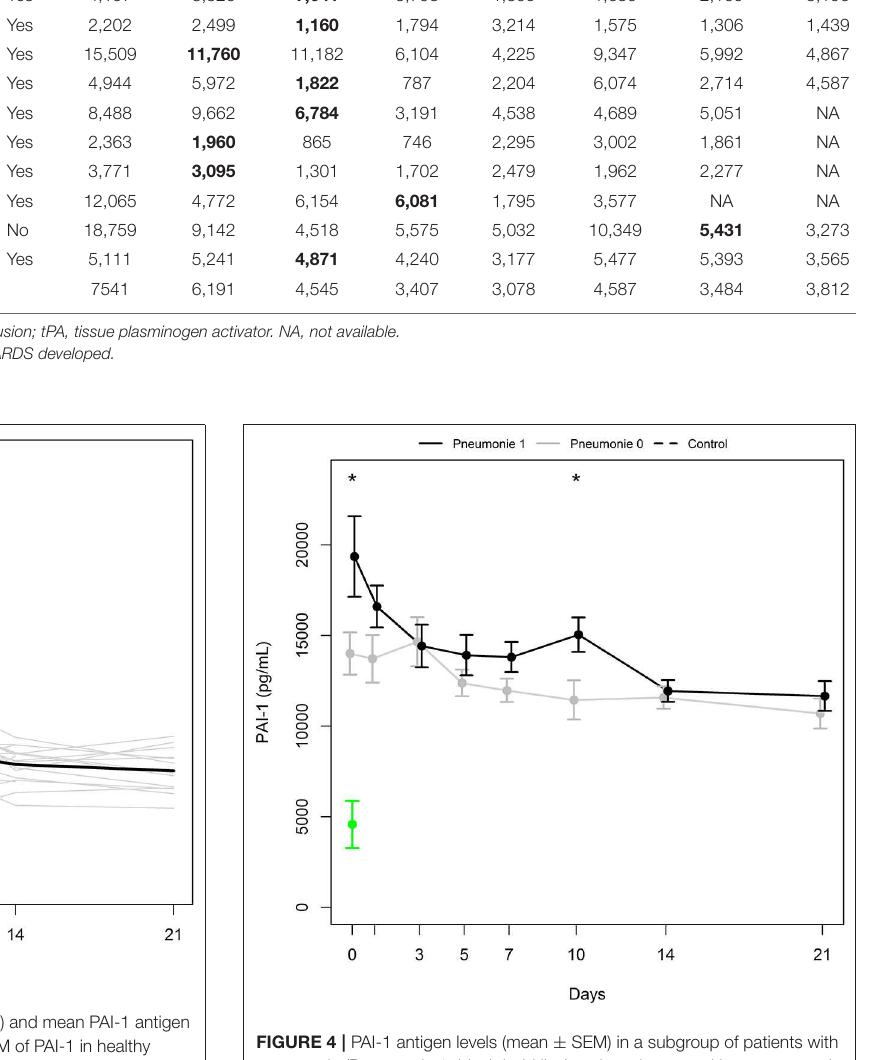
FIGURE 4 | PAI-1 antigen levels (mean ± SEM) in a subgroup of patients with pneumonia (Pneumonia 1, black bold line) and a subgroup with no pneumonia (Pneumonia 0, gray bold line). *Indicates significant difference ( p ≤ 0.031) between Pneumonia 1 and Pneumonia 0 group. Mean ± SEM of PAI-1 in healthy controls